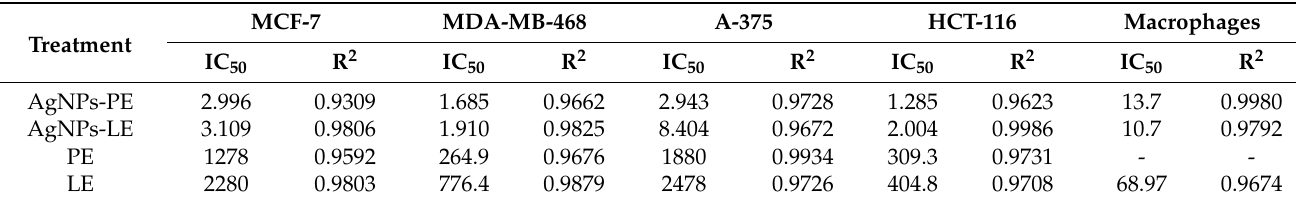
Table 1. Antiproliferative activities (IC 50 ( µ g/mL)) of AgNPs-PE, AgNPs-LE, PE in cancer cell lines and macrophages. All the experiments were performed in